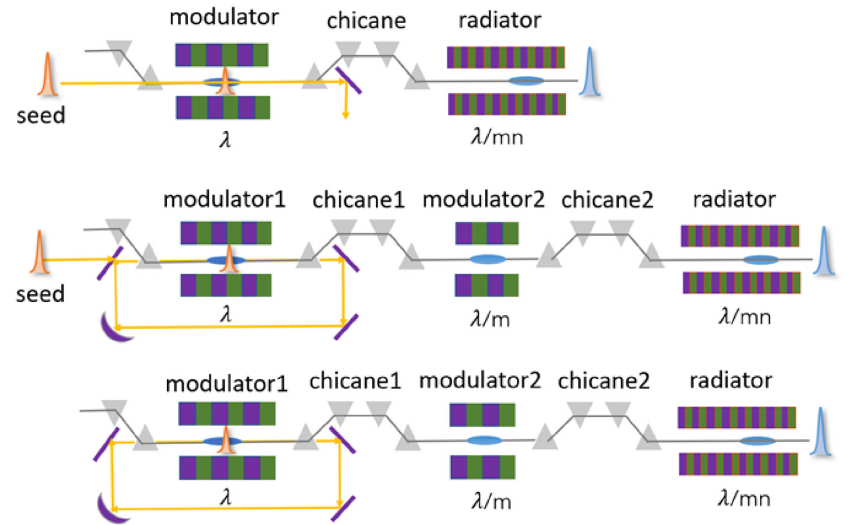
FIG. 1. In a standard single-stage HGHG scheme (top), the modulator is resonant at the fundamental wavelength of the seed laser, and chicane is responsible for density modulation; the radiator is tuned to a harmonic of the seed laser wavelength. In the harmonic optical klystron resonator-radiator configuration, either starting with an external seed laser (middle) or starting from shot noise (bottom), we need a pair of modulator-chicane modules. Modulator 1 is resonant at the fundamental wavelength of the seed laser, and modulator 2 is tuned to a harmonic of the first modulator. Chicane 1 is responsible for increasing the bunching at the fundamental wavelength, while chicane 2 is responsible for longitudinal density modulation at a harmonic of the seed laser wavelength. The final FEL amplification of high harmonic radiation is taking place in the